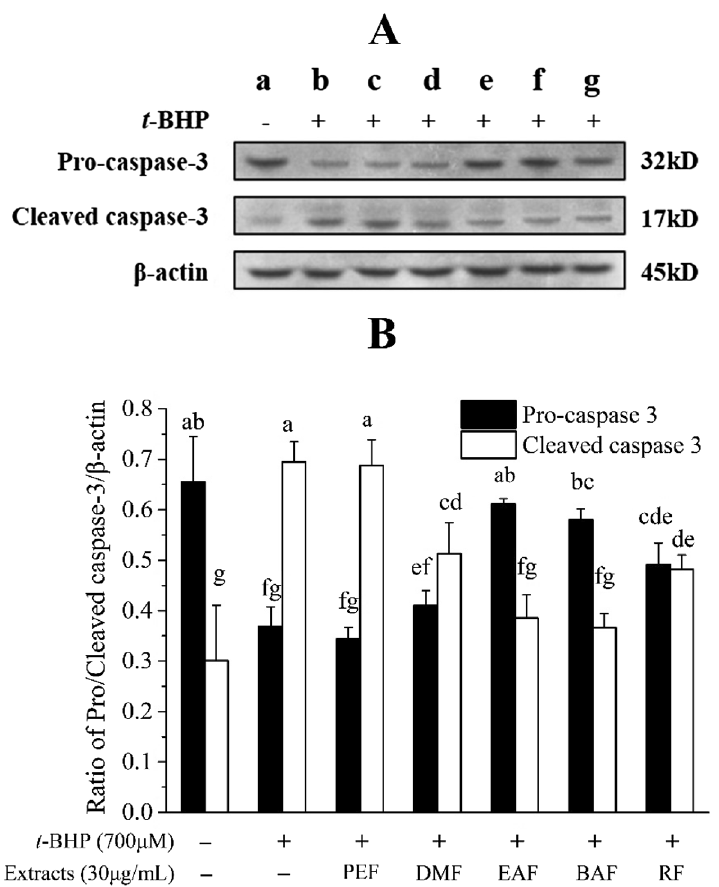
Figure 4. Effects of extracts on the expression of caspase-3 level in HepG2 cells. HepG2 cells were treated with 30 μg/mL samples for 6 h before being exposed to t -BHP (700 μmol/L) for 3 h. ( A ) The expressions of pro- caspase-3, cleaved caspase-3 and β-actin were used for normalization and verification of protein loading; ( B ) Quantitative pro-caspase-3 and cleaved caspase-3 expression after normalization to β-actin. ( a ) Control; ( b ) 700 μmol/L t -BHP treated; ( c ) 30 μg/mL PEF + 700 μmol/L t -BHP; ( d ) 30 μg/mL DMF + 700 μmol/L t -BHP; ( e ) 30 μg/mL EAF + 700 μmol/L t -BHP; ( f ) 30 μg/mL BAF + 700 μmol/L t -BHP; ( g ) 30 μg/mL RF + 700 μmol/L t -BHP. Different letters above bars indicate significant difference (by ANOVA, p < 0.05). Result are expressed as mean ± SD (n ≥ 3). + , treated; −,